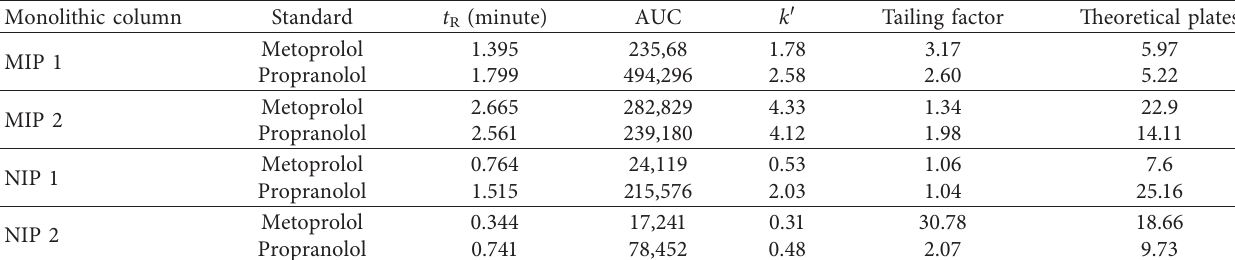
Figure 8: Chromatograms of metoprolol standard solution using the monolithic column MIP 1 (a); MIP 2 (b); and propranolol standard solution using monolithic column MIP 1 (c); MIP 2 (d). Table 8: Chromatographic profile of metoprolol and propranolol standard solutions.